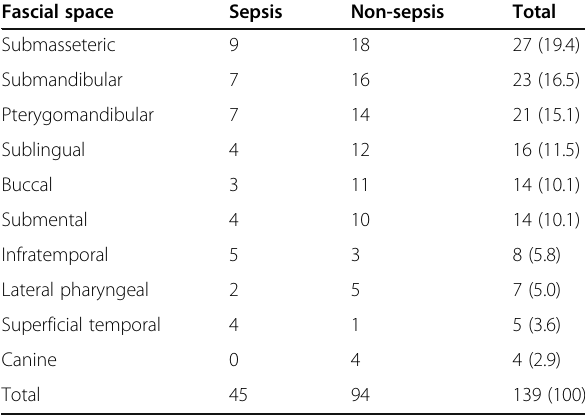
Table 3 Distribution of the involved fascial space Fascial space